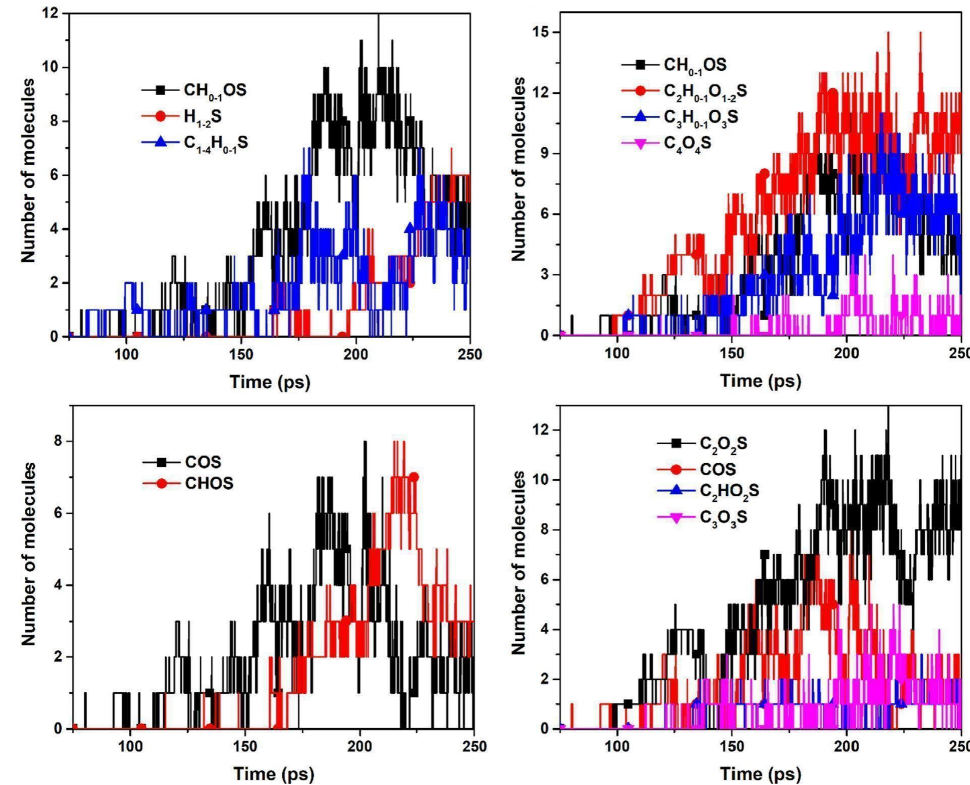
Figure 13. Distributions of the S-containing gaseous products obtained from the CO–petcoke ReaxFF simulations heated to 3000 K [86]. Reprinted/adapted with permission from Ref. [86]. 2019, Fuel.